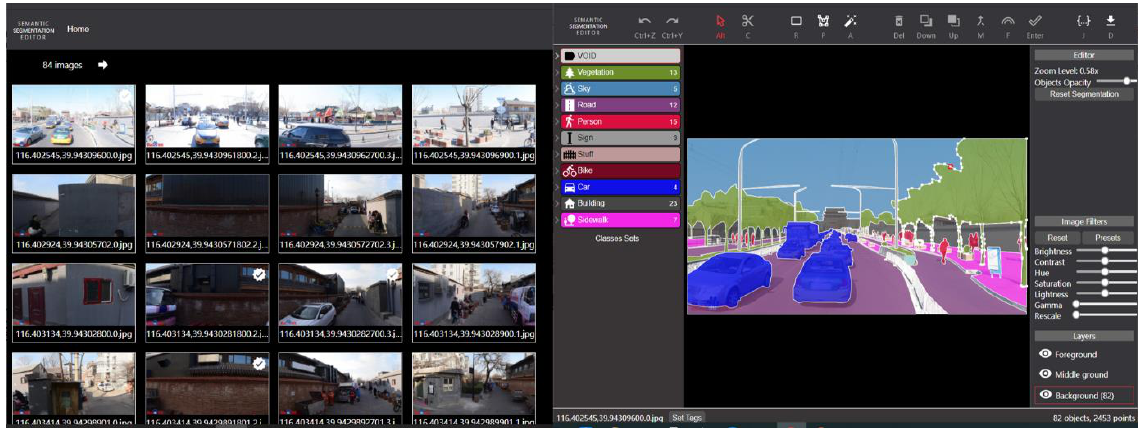
Figure 2. Semantic segmentation editor platform.